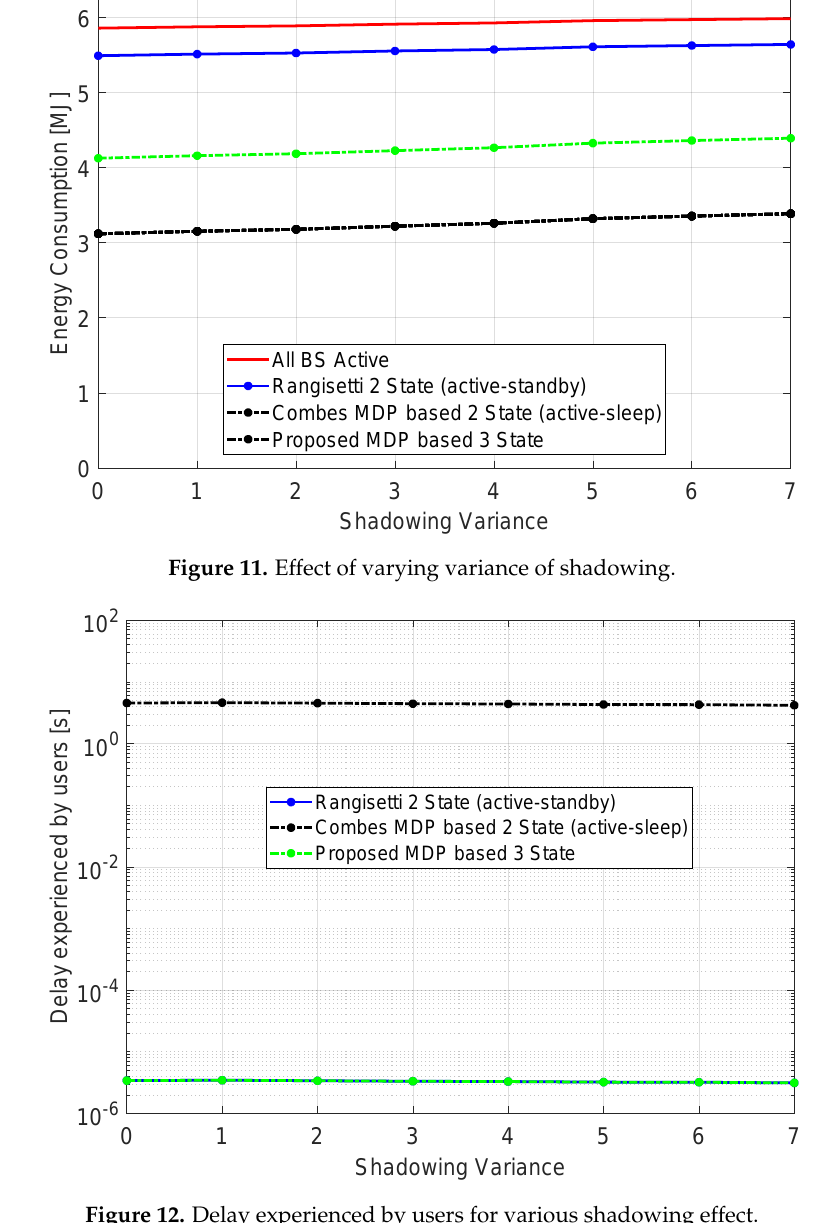
Figure 12. Delay experienced by users for various shadowing